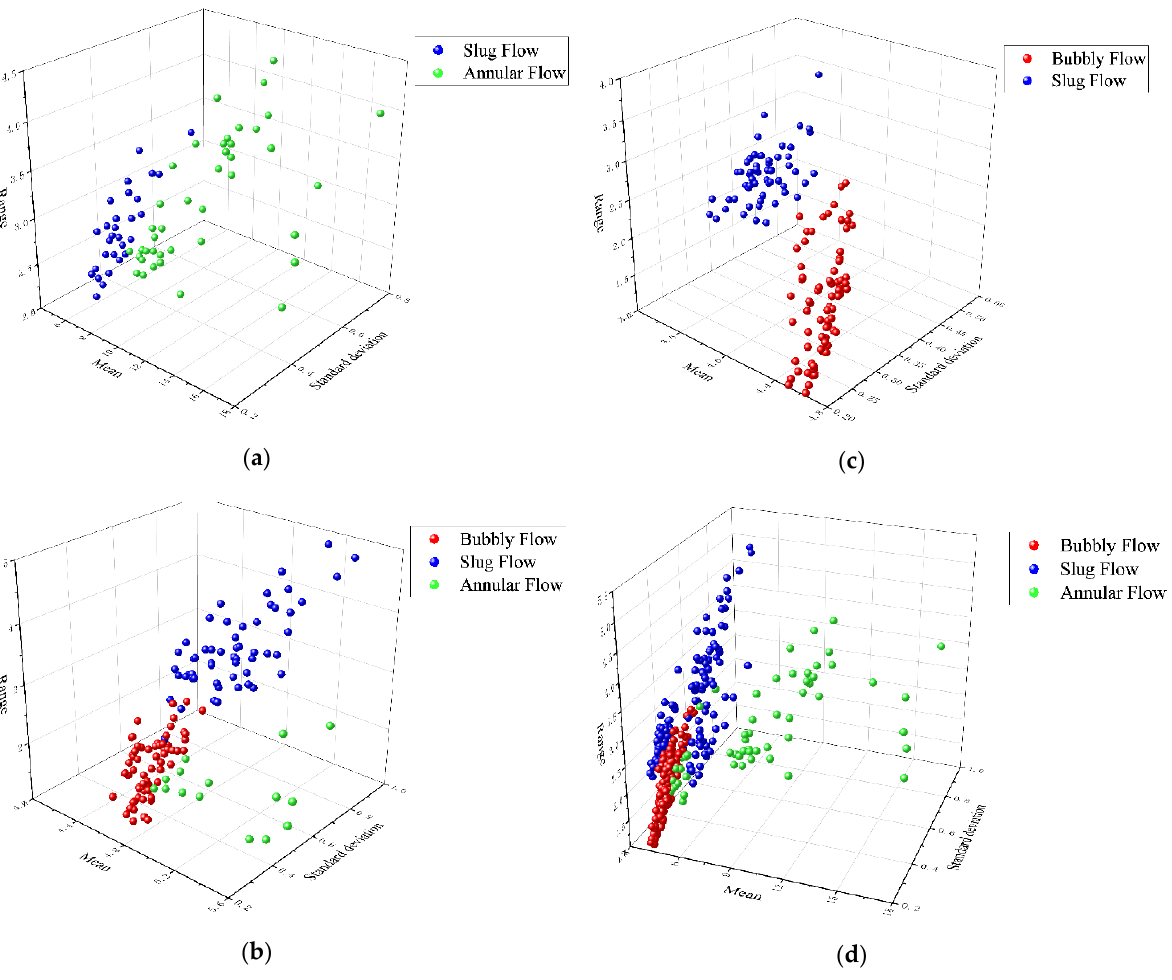
Figure 6. Diagram of time domain characteristic parameter distribution. ( a ). Time domain charac- teristic parameter distribution in porous bed with a particle diameter of 1.5 mm. ( b ). Time domain characteristic parameter distribution in porous bed with a particle diameter of 3 mm. ( c ). Time do- main characteristic parameter distribution in porous bed with a particle diameter of 6 mm. ( d ). Time domain characteristic parameter distribution in all porous beds.